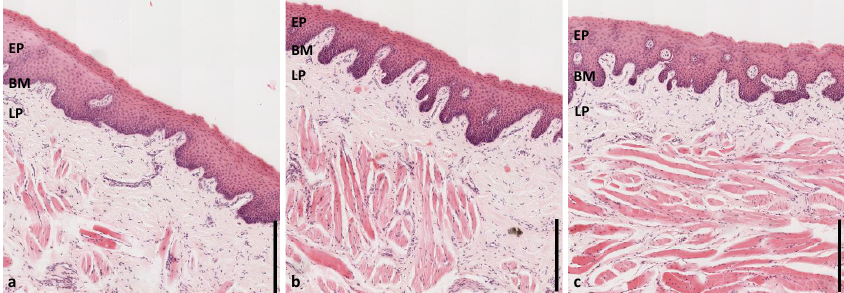
Figure A5. Supplementary HE stained histological cross sections of the human alveolar mucosa [44]. EP: epithelium, BM: basement membrane, LP: lamina propria, Scale bar: 200 µ m.